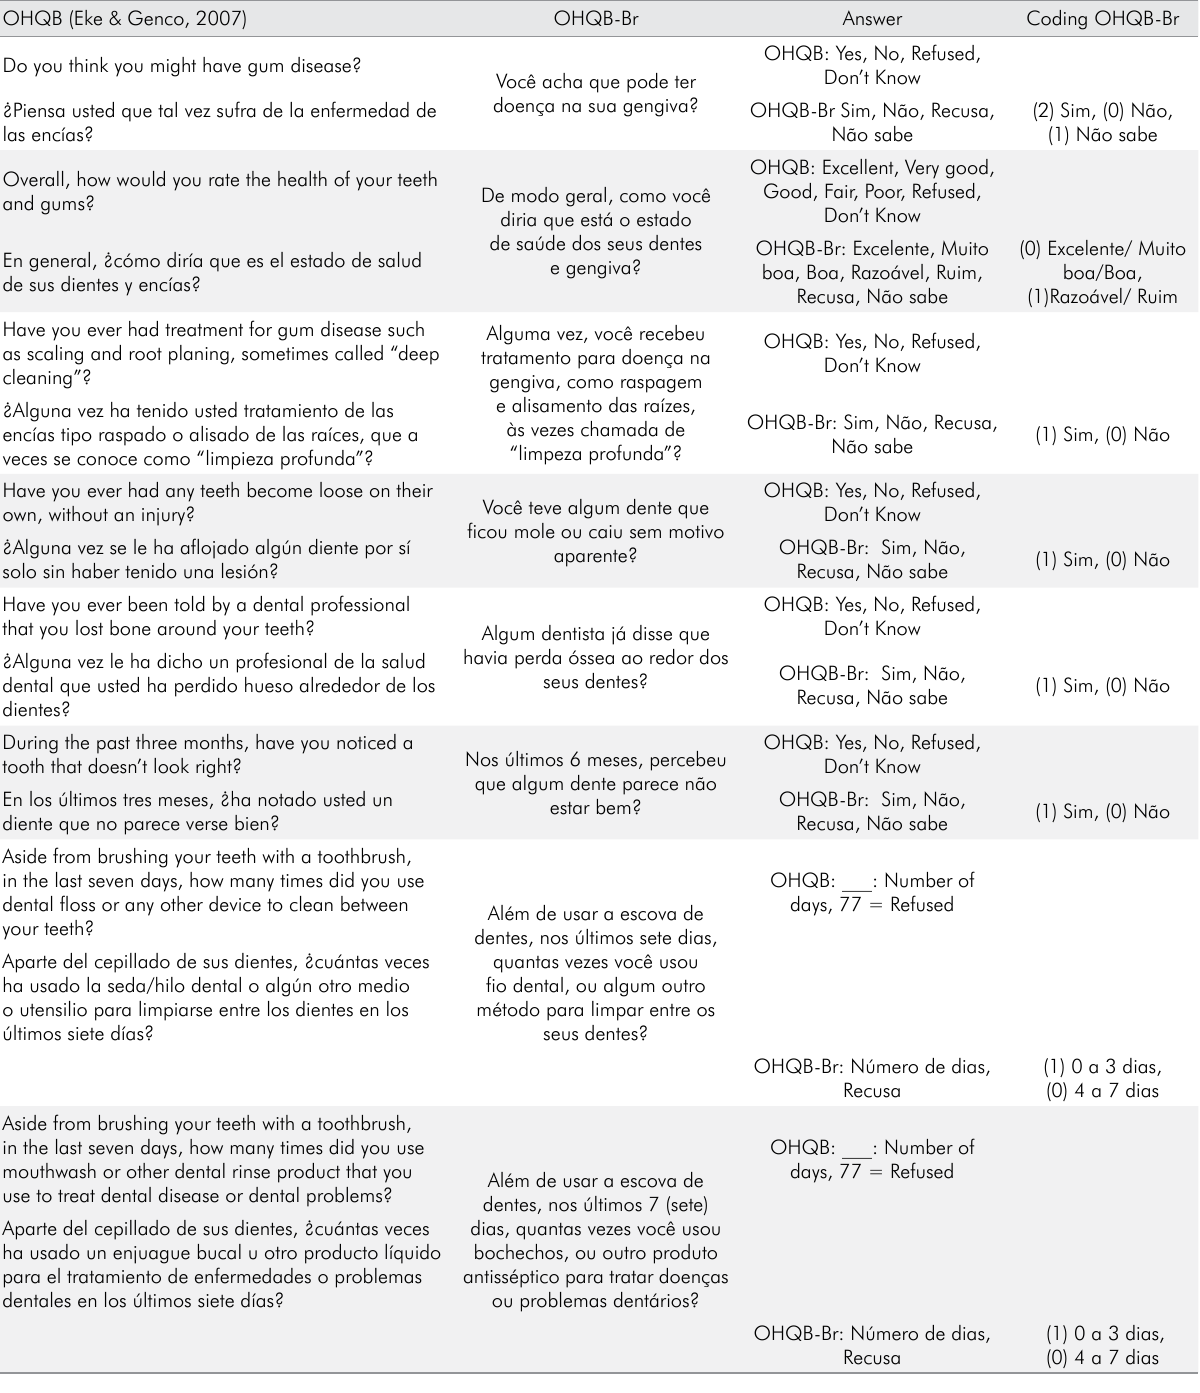
Figure 1. OHQB and OHQB-Br questionnaire: questions and answers